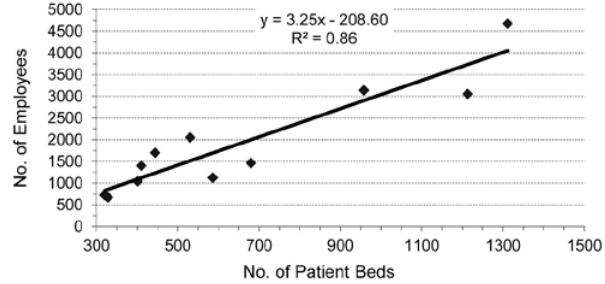
Fig. 7. Number of employees vs. number of patient beds in acute-care